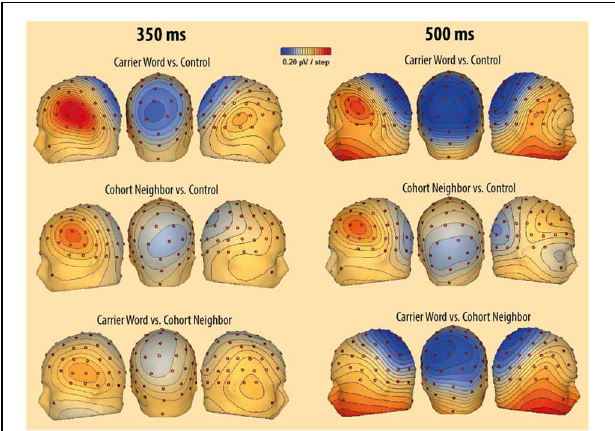
FIGURE 2 | Target-locked ERP waveforms elicited across the whole experiment with four repetitions of the target words. ERPs are collapsed for electrode leads establishing the three Regions of Interest that entered ERP analysis. Brain responses to the carrier word condition (e.g., ano-Anorak) are given in solid black lines, to the cohort neighbor condition (ana-Anorak) in solid red lines, and to the unrelated condition (e.g., paste-Anorak) in dashed blue lines. The target word onset is indicated by a vertical line. The approximate behavioral response for the slowest condition (partial overlap) is marked by a gray arrow.